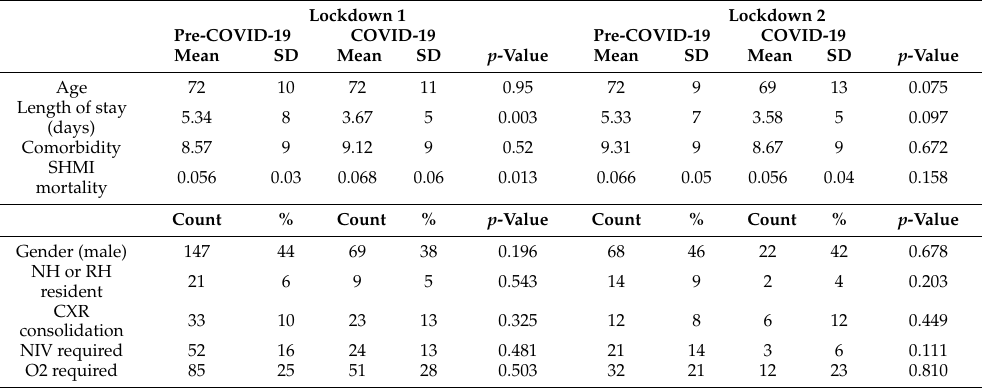
Table 4. Descriptive statistics for Lockdown 1 and 2 in pre-COVID-19 and COVID-19